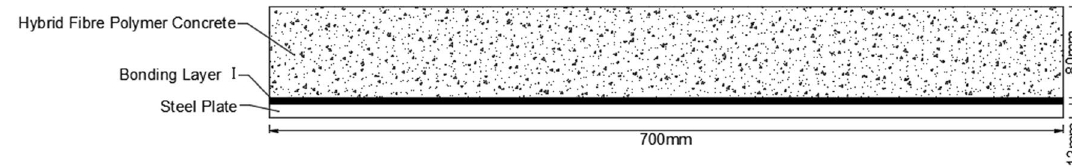
Figure 2. Single-layer pavement structure.